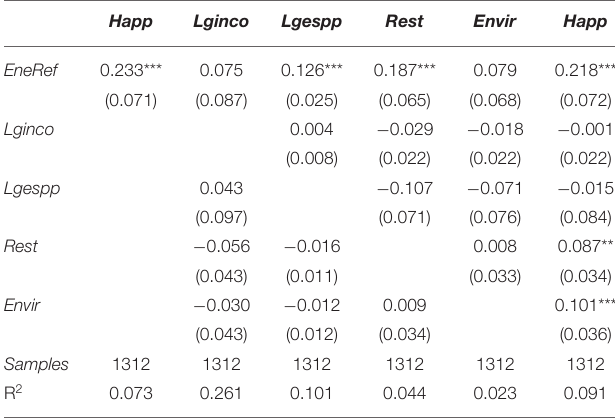
TABLE 5 | Regression results of benchmark model and mediation model after propensity score matching.